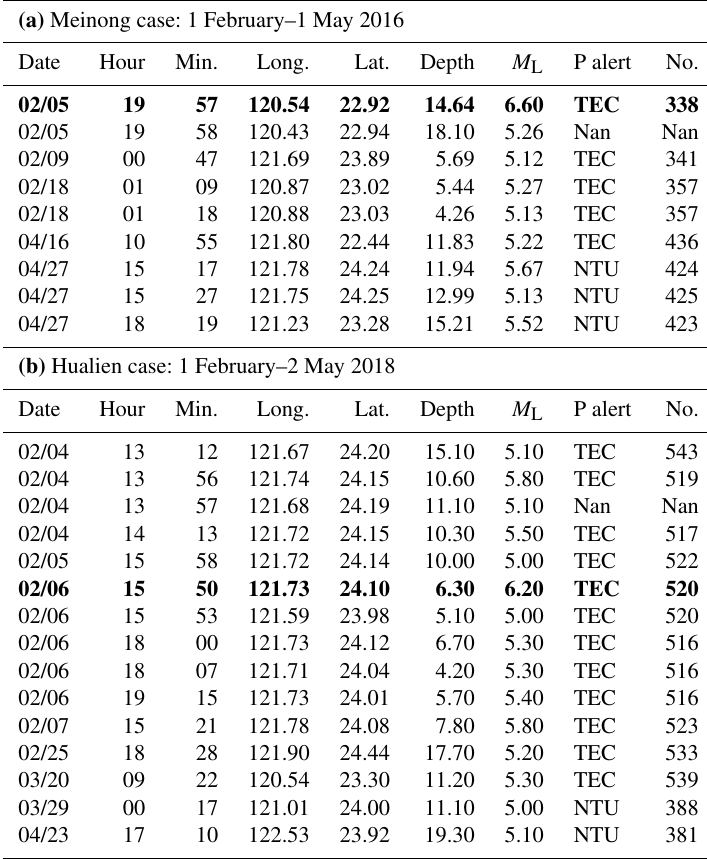
Table 1. Earthquakes occurring in the forecast interval. Date format: